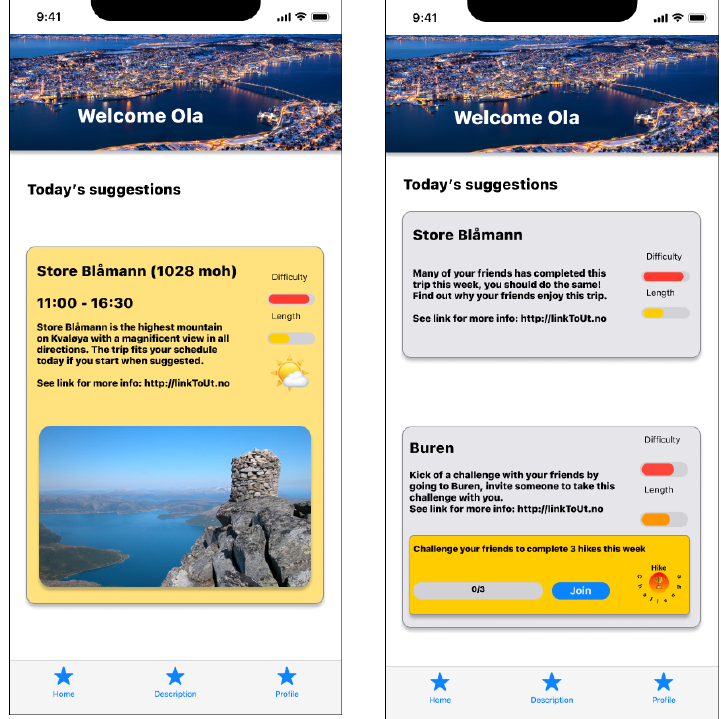
Figure .: Implementation of the simplification eect